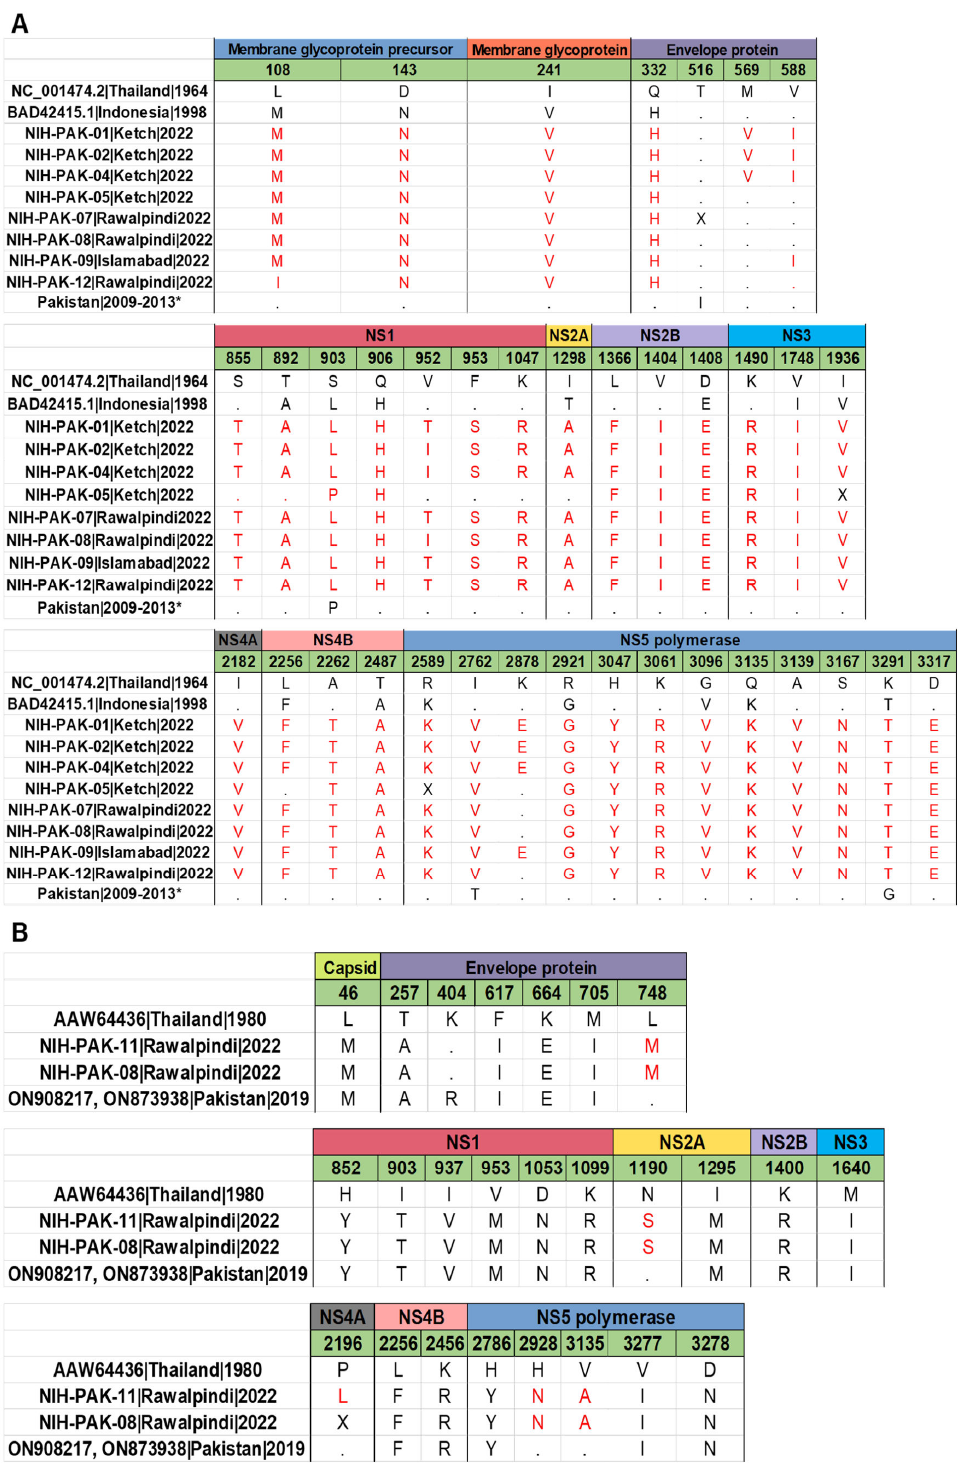
Figure 4. ( A ) Amino acid variation in the DENV2 study isolates in comparison with the reference strain and previously reported sequences from Pakistan. ( B ) Amino acid variation in the DENV1 study isolates in comparison with the reference strain and previously reported sequences from Pakistan. The amino acid differences are highlighted in red. X represents the missing amino acid at that position and dot (.) represents the same amino acid as present in the reference